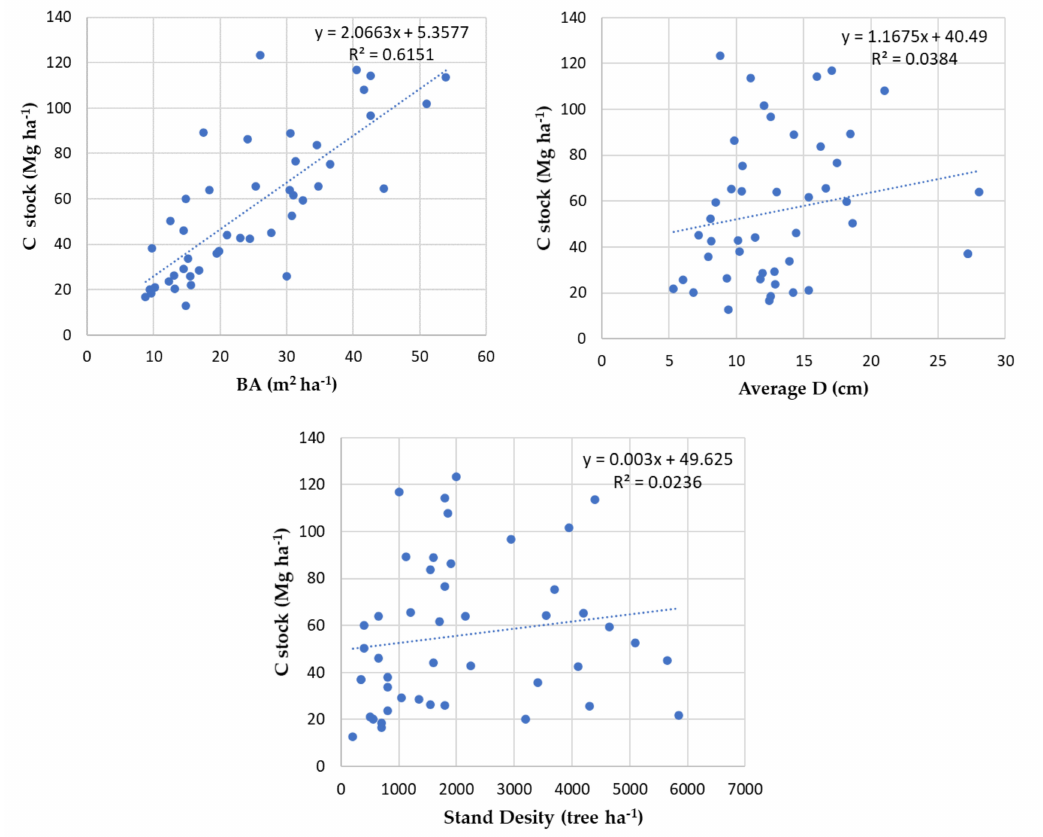
Figure 3. Correlation between C stock and average diameter (D), stand density and basal area (BA) in each measured